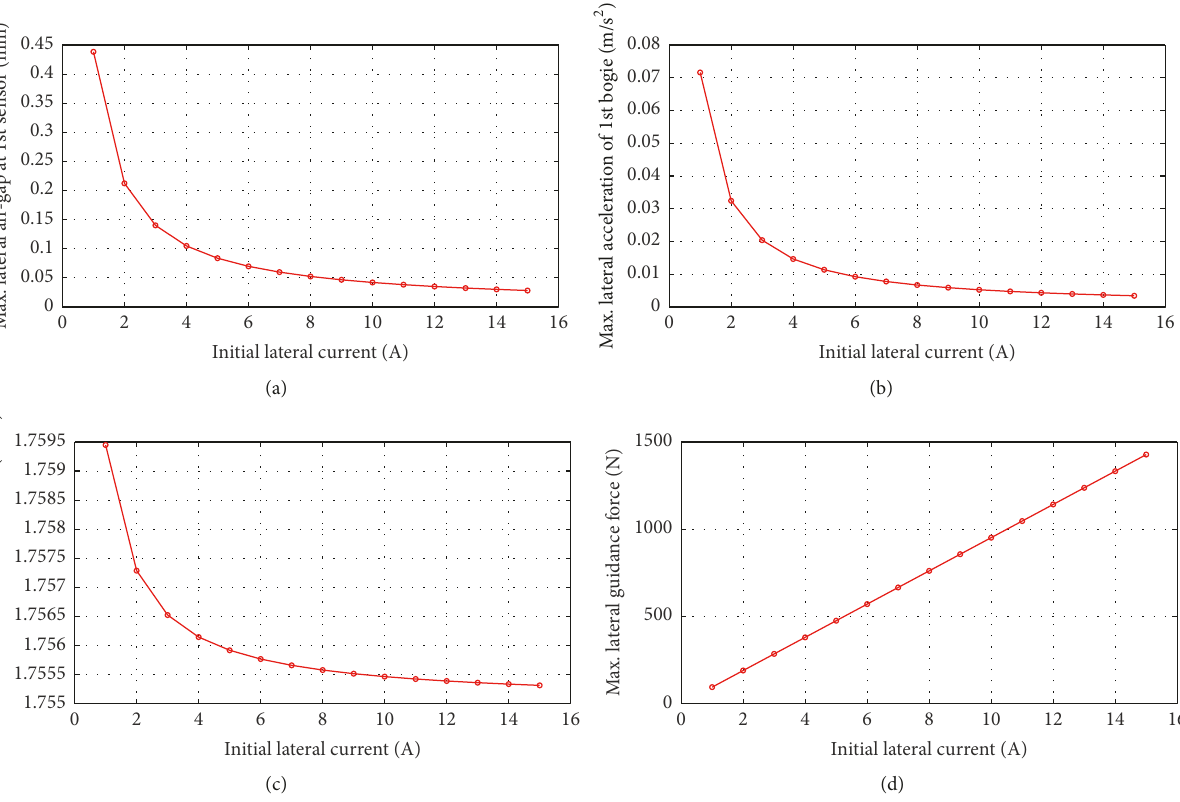
Figure 10: Maximum responses of maglev vehicle: (a) lateral air-gap at 1st sensor, (b) lateral acceleration at center of 1st bogie, (c) lateral acceleration at center of cabin, and (d) lateral guidance force at 1st electromagnet of 1st bogie.